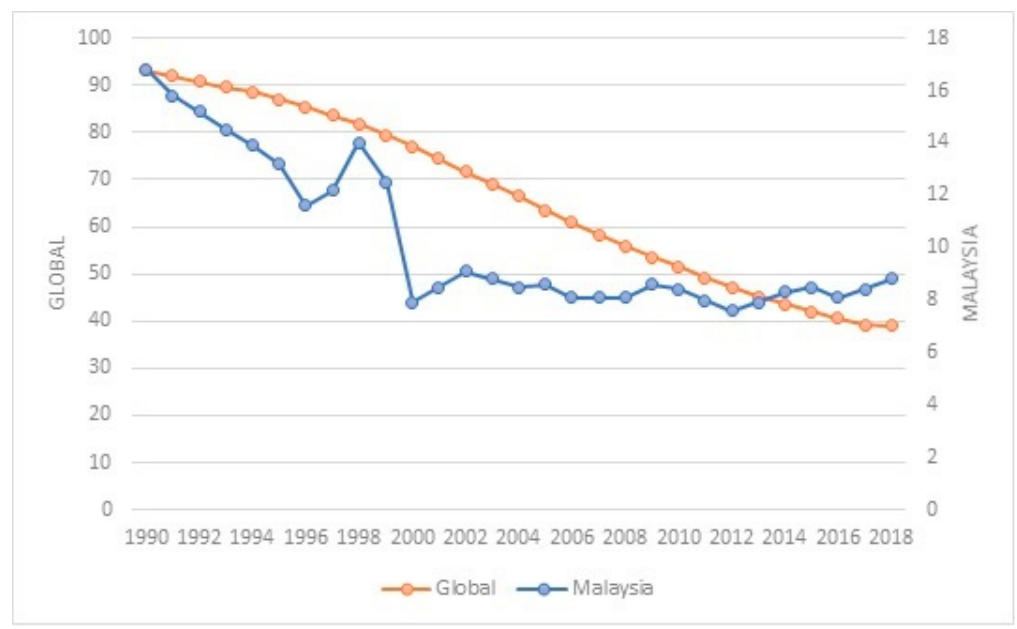
Figure 3. Under-five mortality rate from 1990 to 2018. Source: Department of Statistics Malaysia and United Nations Inter-Agency Group for Child Mortality Estimation 2018.